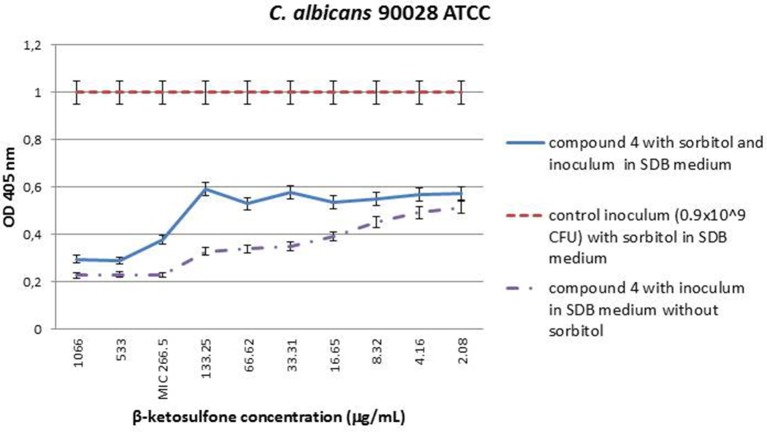
MIC values (μg/mL) of β-ketosulfone (compound 4) in the presence of sorbitol (0.8 M) against C. albicans 90028. The solutions of compound 4 were dissolved in water with 0.66% (v/v) addition of DMSO. The yeast cells suspension at final density of 0.9 × 109 cfu/mL SDB medium with sorbitol at final concentration of 0.8 M and DMSO at 0.66% was used in the experiment. Additionally, to accurately determine MICs for 90028, compound 4 at the range of concentrations: 2.08–1066 in SDB medium without sorbitol was used.